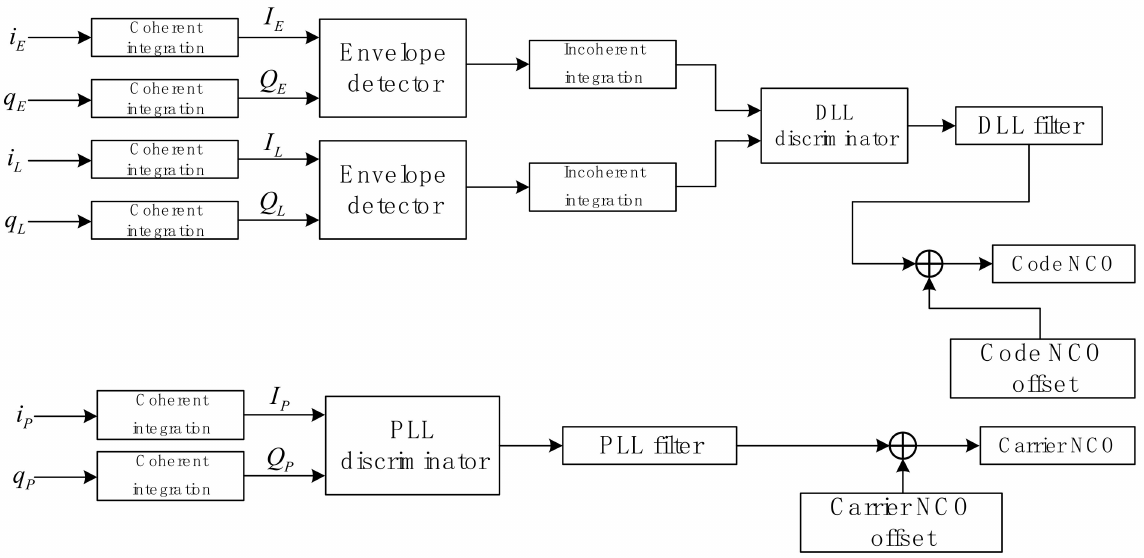
Figure 1. Flow chart for the acquisition and tracking loop structure.